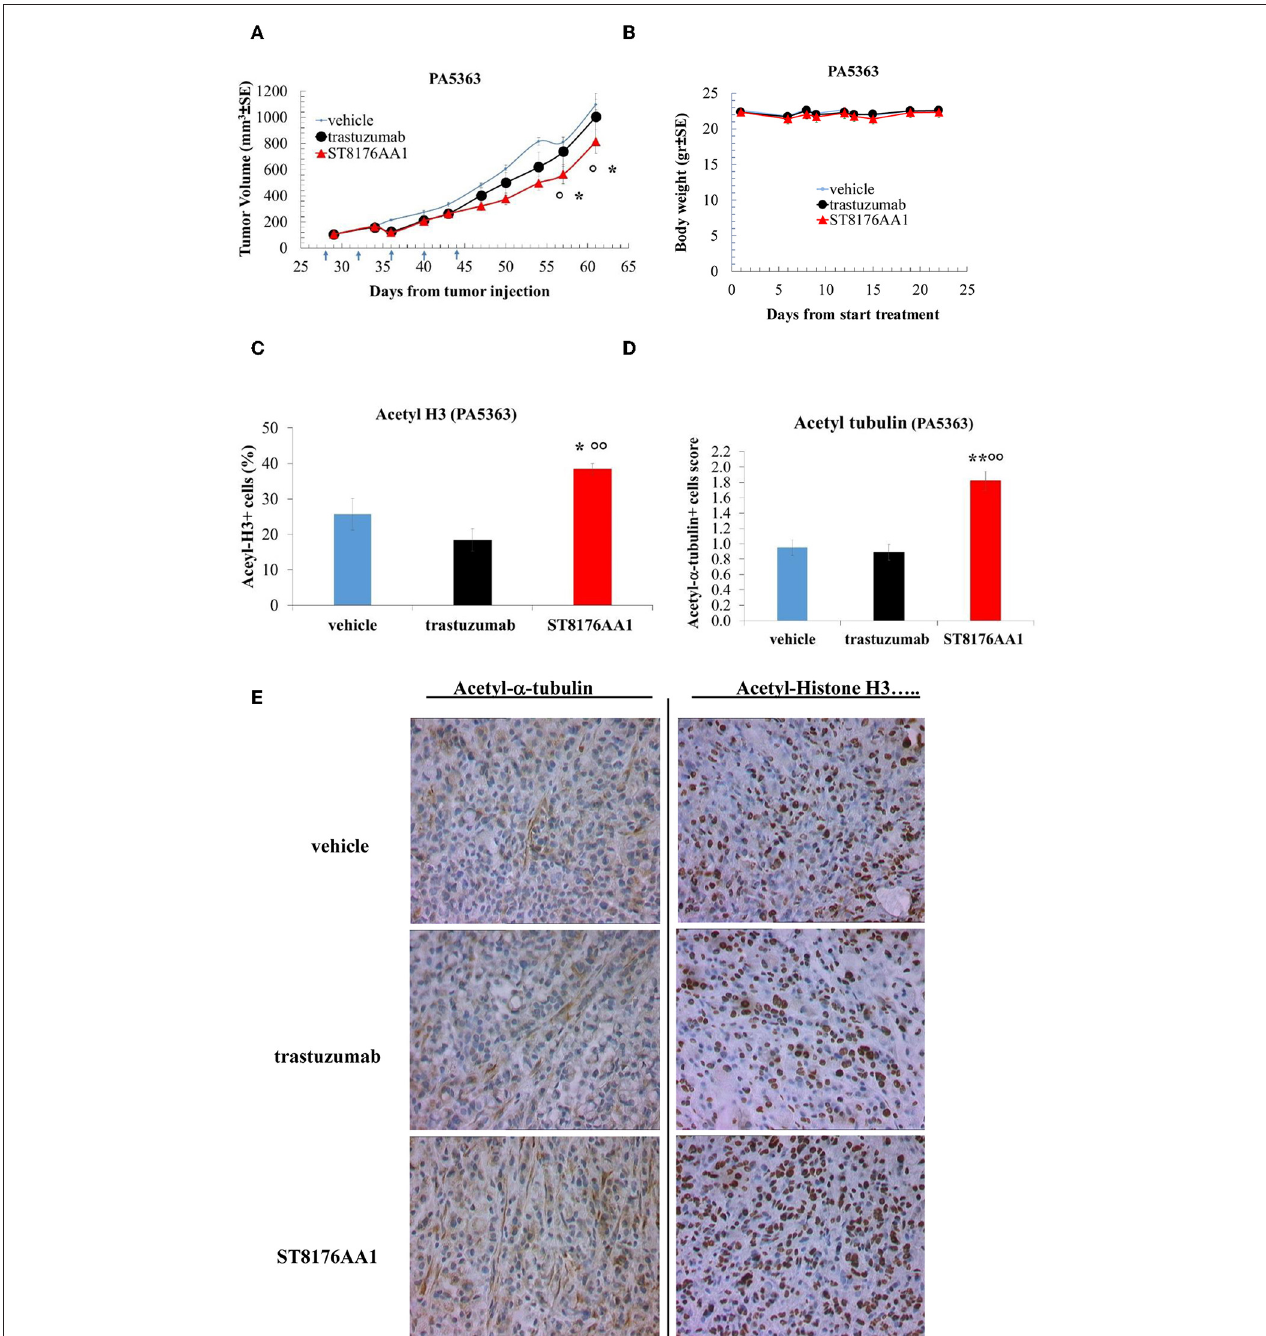
FIGURE 10 | Anti-tumor efficacy of ST8176AA1 in PDX pancreatic carcinoma model of patient PA5363. (A) NODSCID mice (10/group) bearing patient-derived pancreatic carcinomas PA5363 were treated i.p. with ST8176AA1 or trastuzumab (5 doses of 15 mg/kg once every 4 days, starting 28 days after tumor transplantation as indicated by arrows in the graph). One group received vehicle (PBS) with the same schedule. Tumor growth was monitored using a Vernier caliper. Body weight in panel (B). Data are expressed as mean ± SE. Statistical analysis by Mann-Whitney’s test. * P < 0.05 vs. vehicle and ◦ P < 0.05 vs. trastuzumab. (C,D) Tumor masses at the end of the study were analyzed by immunohistochemistry. Cells positive for acetyl-histone H3 (C) and for acetyl- α -tubulin (D) from PA5363 were counted by two independent observers in five randomly selected fields. Data in the graph are expressed as the mean of positive cells × 100/total cells ± SE or as score with negative staining, score 0; 1-20% positive cells, score 1 + ; 21-50% positive cells, score 2 + > 50% positive cells, score 3 + . Statistical analysis by Mann-Whitney’s test. * P < 0.05 vs. vehicle-treated group; ◦◦ P < 0.01 vs. trastuzumab. (E) Representative immunohistochemistry pictures for acetyl- α -tubulin and acetyl-histone H3 are shown. Images captured using 40 × magnification. Scale bar: 500 µ m.